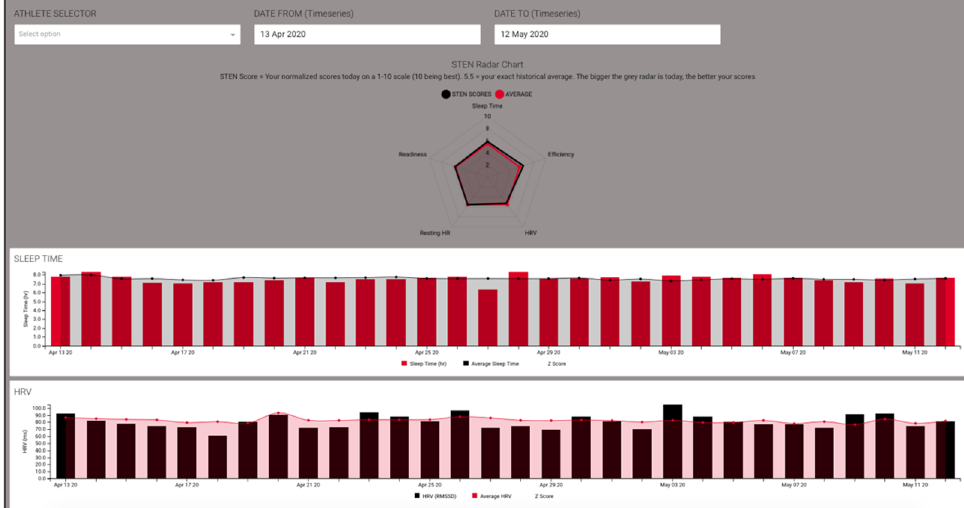
Figure 7. Sleep and Sleep Physiology Time-Series Dashboard.